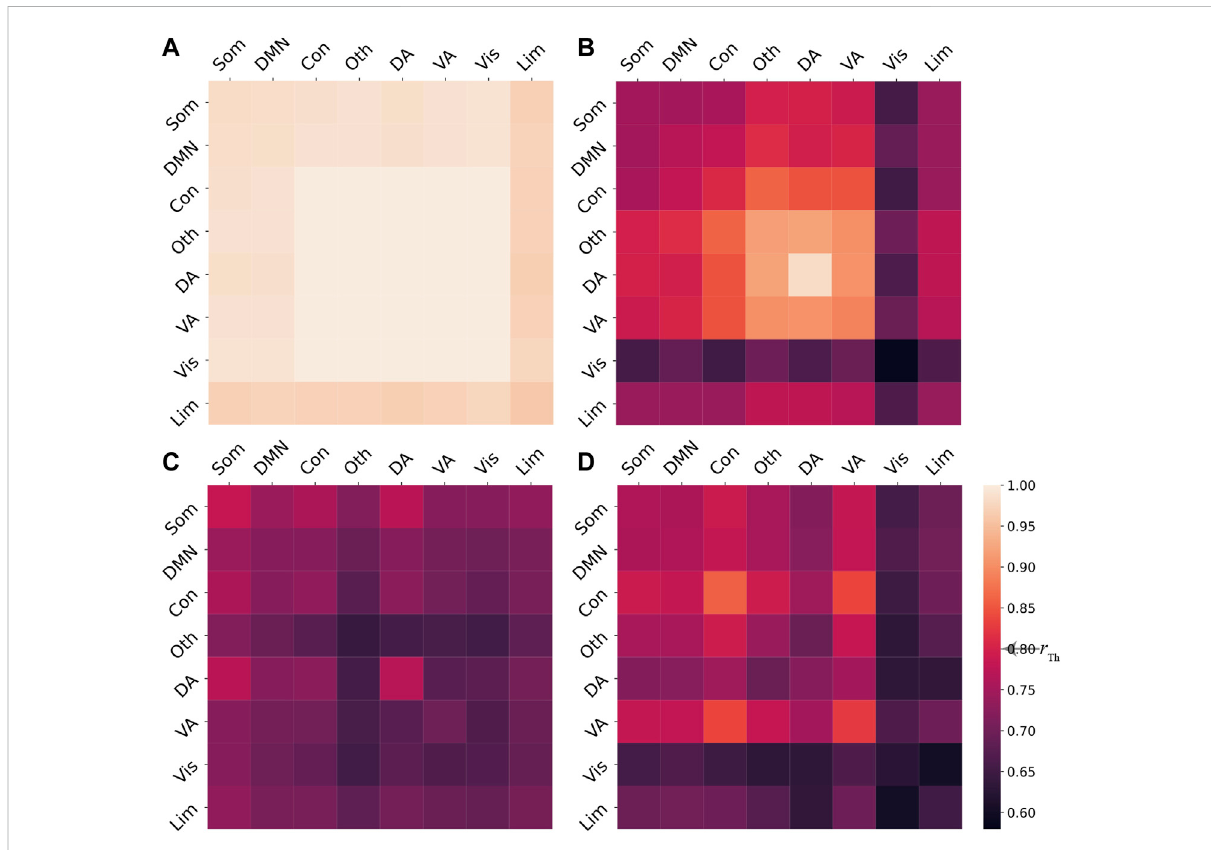
FIGURE 8 (B) Chimera state with the coupling strength c (C) Metastable state (A) Coherent state generated with the coupling strength c 5 = 1000. 5 = 330. with the coupling strength c 5 = 200. In (A – C) , we stimulate the 1-st brain region by applying a constant external input, i.e., P i = 1.15 if i = 1 and P i = 0 otherwise. (D) Chimera state of the brain dynamics without stimulation for c 5 = 330. The order parameter r ξ and a threshold r Th = 0.8 are used to i , ξ j classify the fi nal states of the brain dynamics. The order parameter threshold r Th is marked on the colorbar. To obtain a stationary state, we integrate thebraindynamics Eq.2intime interval [0,150 s]with stepsize=0.001 s,andsettheinitialconditions E i (0)=0.1, I i (0)=0.1with i =1, ... , N